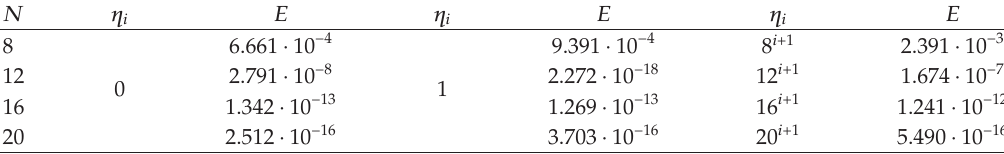
(cid:8) 8 , 12 , 16 , 20. N for N